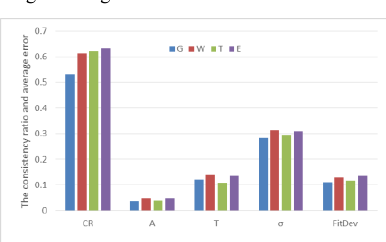
Fig.2 SNR gain and RMSE of different filiters